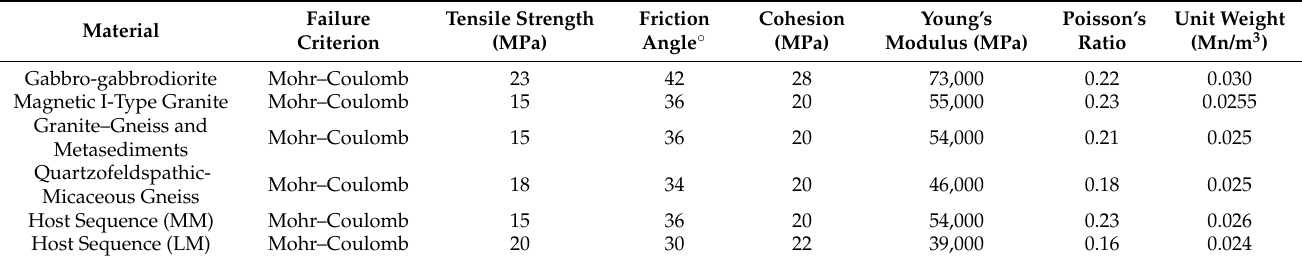
Table 1. FEA input material